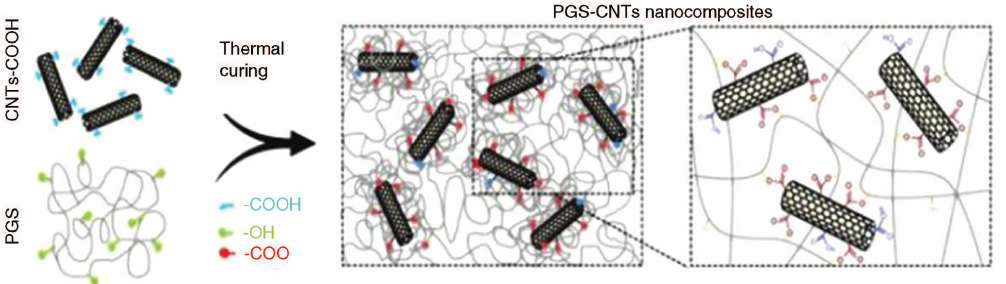
Figure 2: The synthesis and fabrication of PGS-CNT nanocomposites. Reproduced from Ref. [8] with permission of The Royal Society of